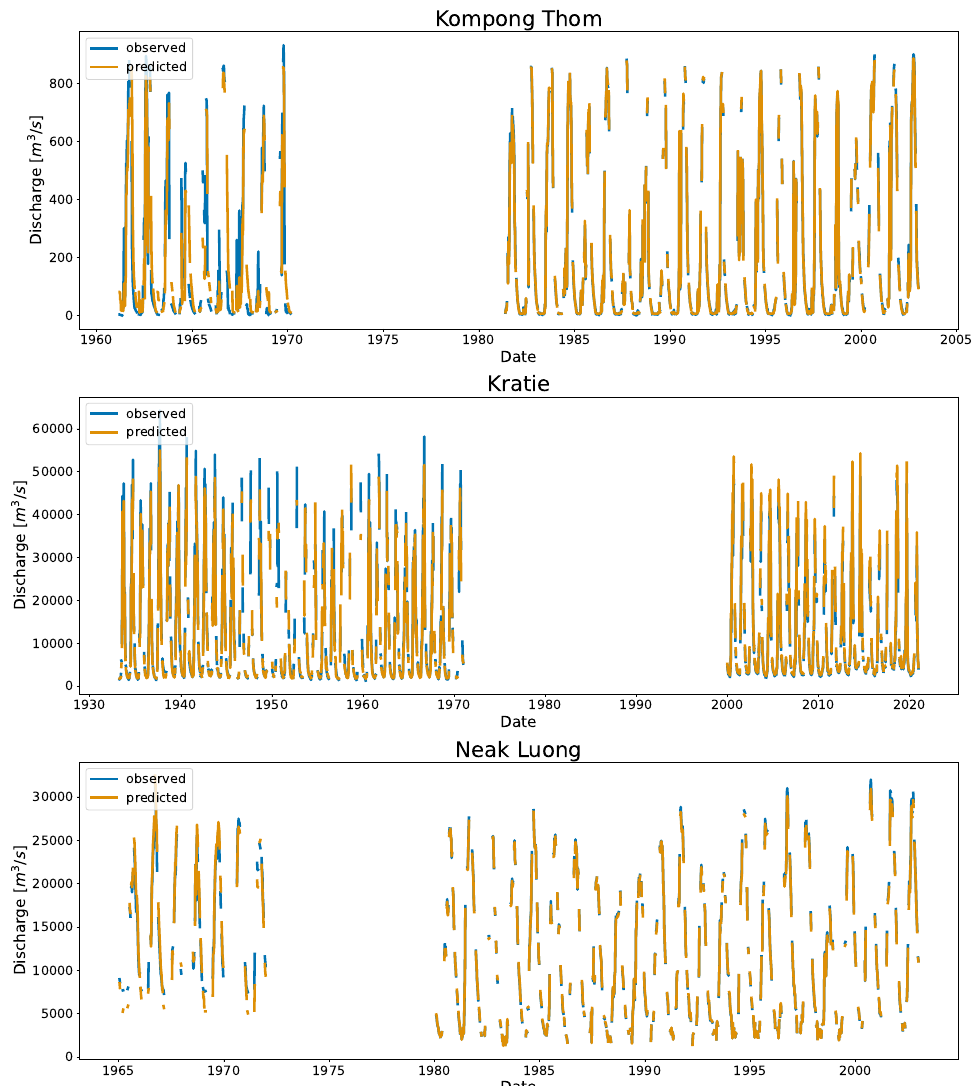
Figure A1. Predicted and observed discharge for Cambodia. For visualization purposes, the data are downsampled into a weekly bin, and the mean values of the discharge failing into the bins for the station are